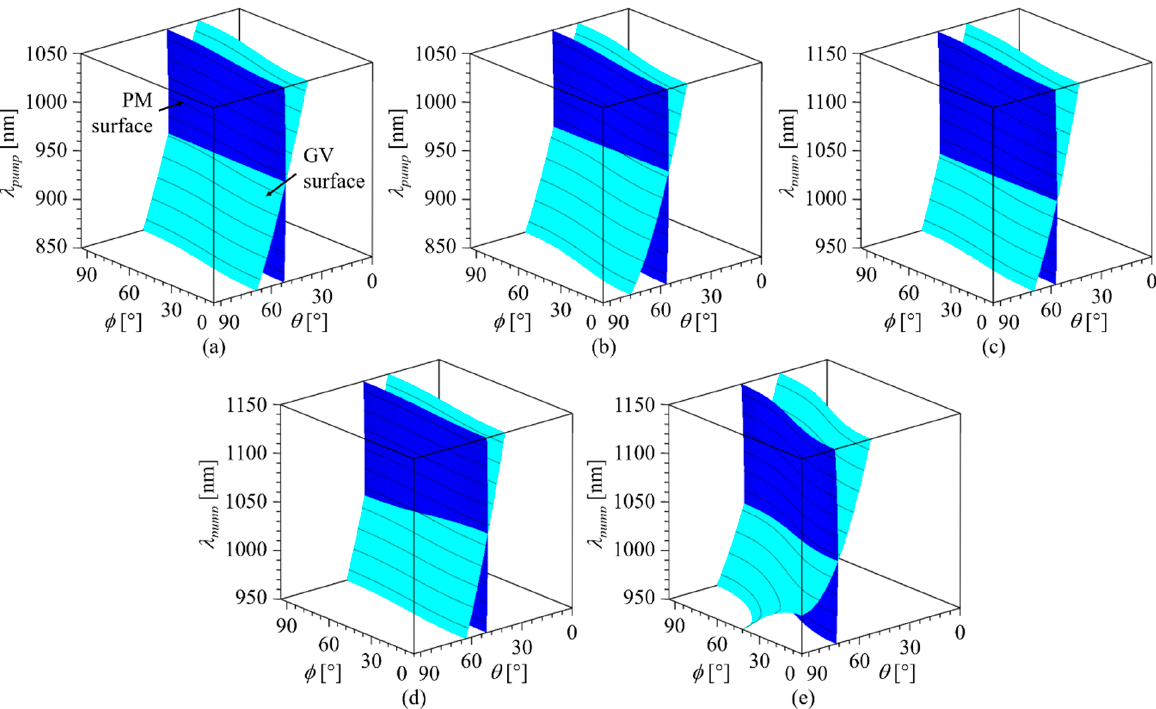
Figure 2. Numerical simulation results of the phase matching (PM) and group velocity (GV) matching for Type II extended phase matching (EPM): ( a ) KTP, ( b ) RTP, ( c ) RTA, ( d ) KTA, and ( e ) CTA. In each graph, the blue and cyan surfaces represent the PM and GV matching, respectively. The crossing line of two surfaces means the range of k p -direction satisfying the EPM.